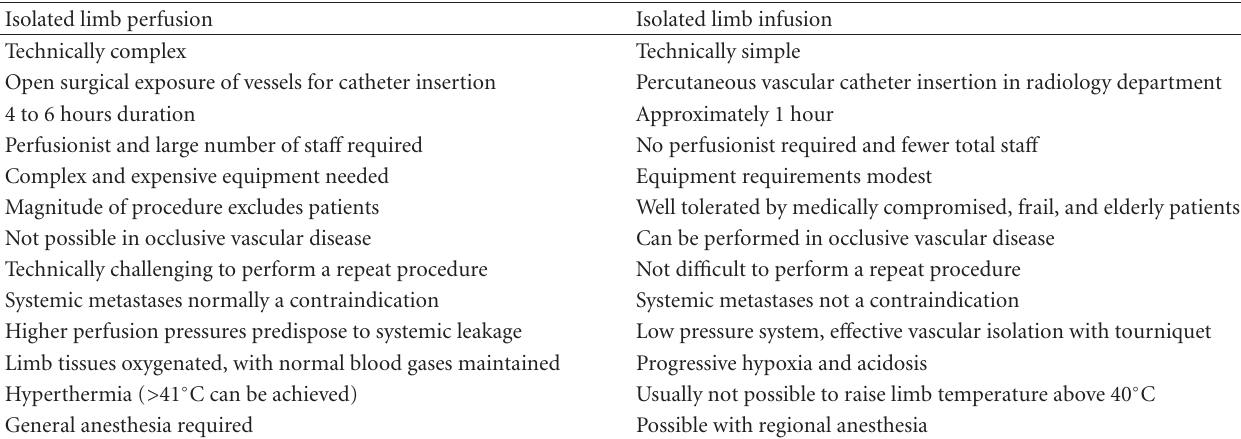
Table 3: Di ff erences between isolated limb perfusion and isolated limb